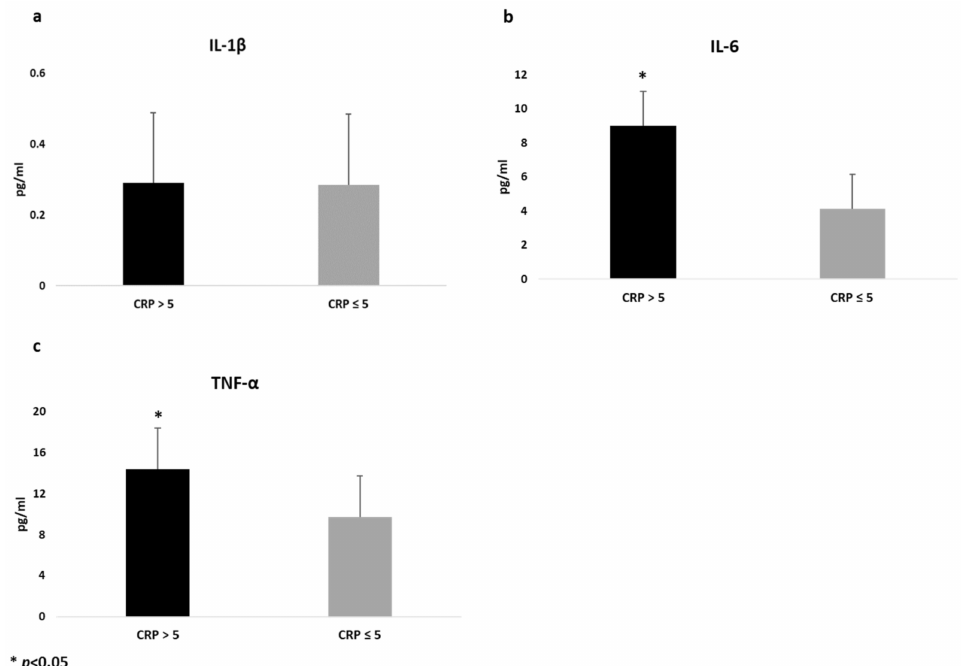
Figure 2. Differences in cytokines values between CD patients with different levels of C reactive protein (CRP), adjusted by sex and treatment. Data are expressed as estimated means and standard error (SE) for Interleukin-1 β ( a ), Interlukin-6 ( b ) and Tumor Necrosis Factor-Alfa ( c ).